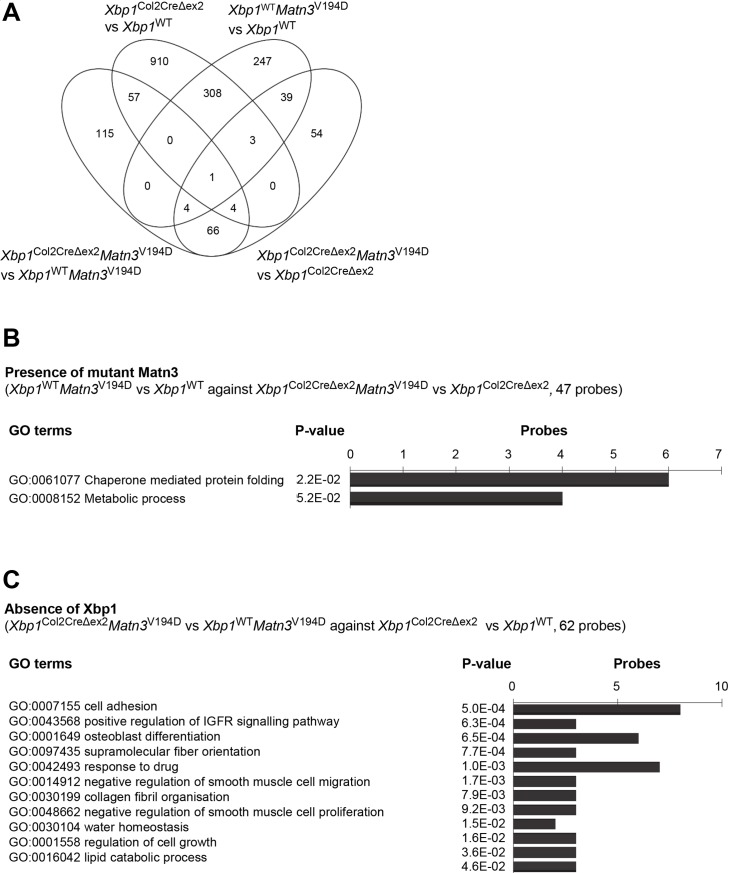
(A) Venn diagram showing an overlap in the significantly upregulated microarray probes from the 4 analyses (Xbp1WT
Matn3V194D vs Xbp1WT, Xbp1Col2CreΔex2
Matn3V194D vs Xbp1Col2CreΔex2, Xbp1Col2CreΔex2
Matn3V194D vs Xbp1WT
Matn3V194D and Xbp1Col2CreΔex2 vs Xbp1WT. (B) A graph showing the GO terms associated with 47 upregulated probes representing the XBP1 independent effect of a MATN3 mutation. (C) A graph showing the GO terms associated with 62 upregulated probes representing the MATN3 mutation independent effect of XBP1 deletion.